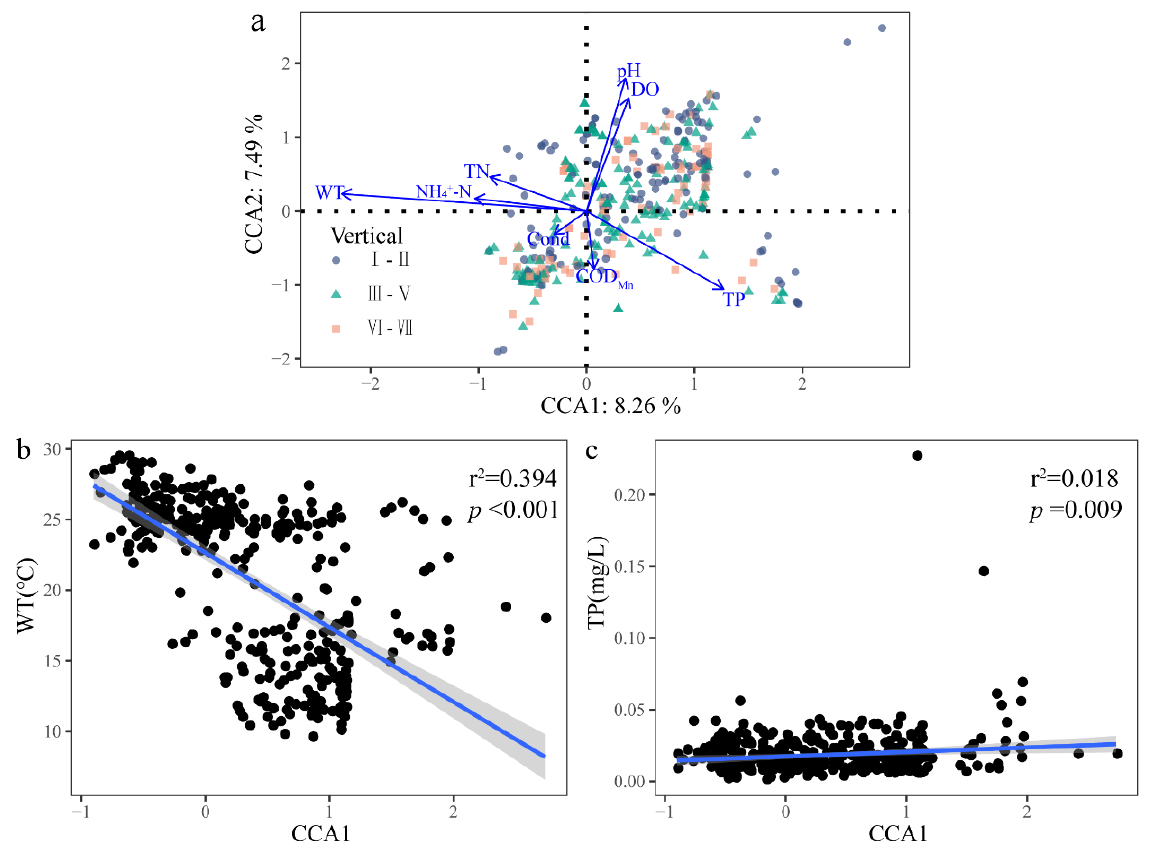
Figure 6. CCA of phytoplankton communities and physicochemical factors in the Danjiangkou Reservoir. (( a ) CCA ordination; ( b ) Linear regression of DO with CCA1; ( c ) Linear regression of TP versus CCA1).